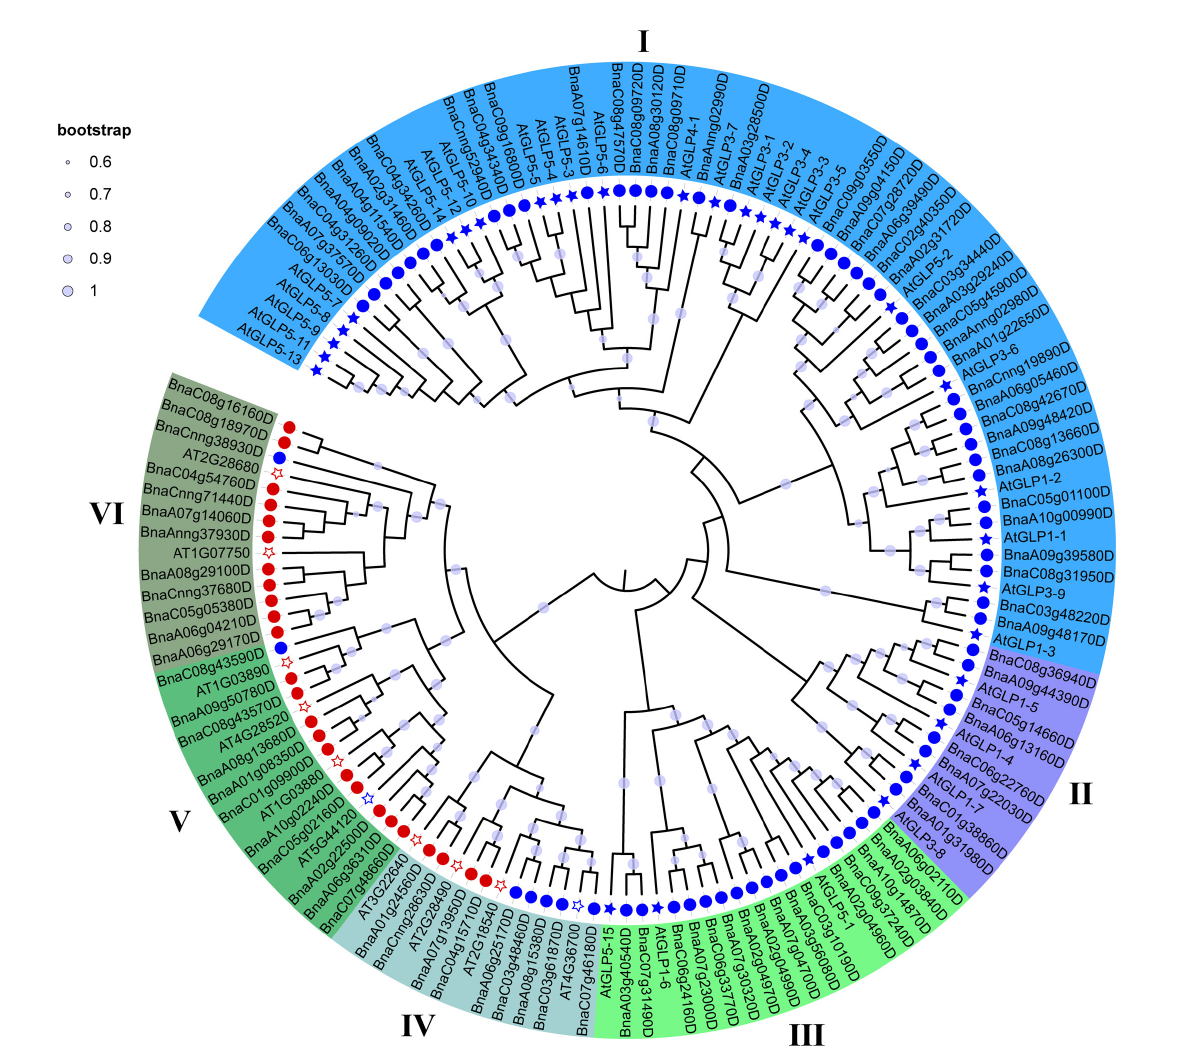
FIGURE1 A neighbor-joining (NJ) phylogenetic tree of CDP proteins in Arabidopsis thaliana (At) and Brassica napus (Bn). All CDP proteins were clustered into six subfamilies, and each subfamily was represented by a different color. Light purple dot on a branch in the figure indicates that the bootstrap support is greater than 60%. Circles refer to BnCDPs, while filled stars refer to AtGLPs identified previously and empty stars refer to AtCDPs identified in this research; Blue and Red refer to CDPs with single or duplicated cupin_1 domain,